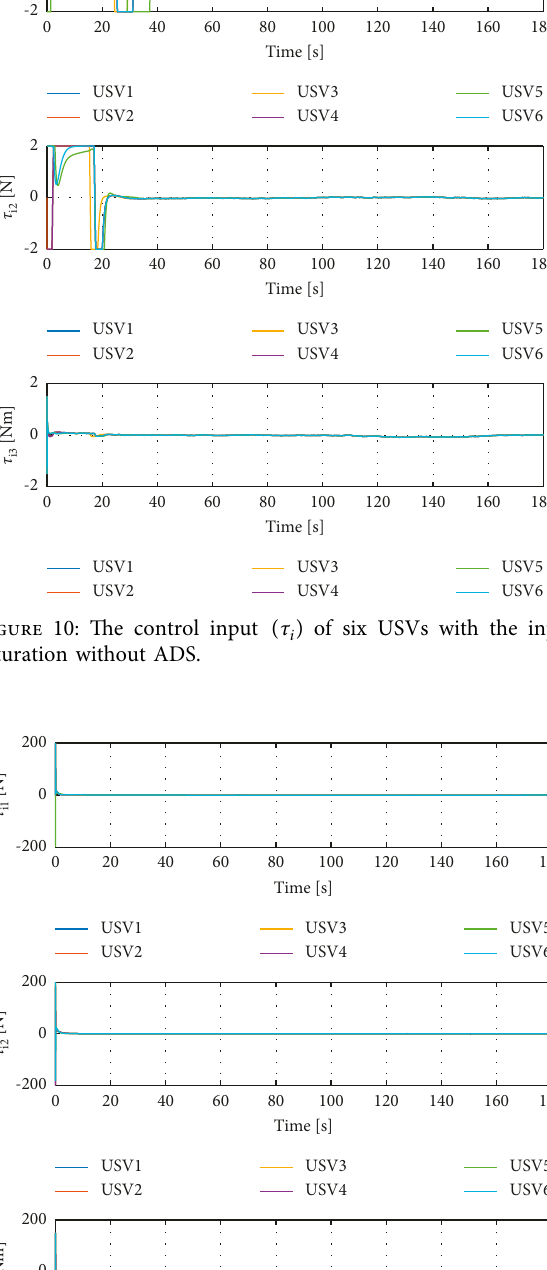
) of six USVs without the actuator i